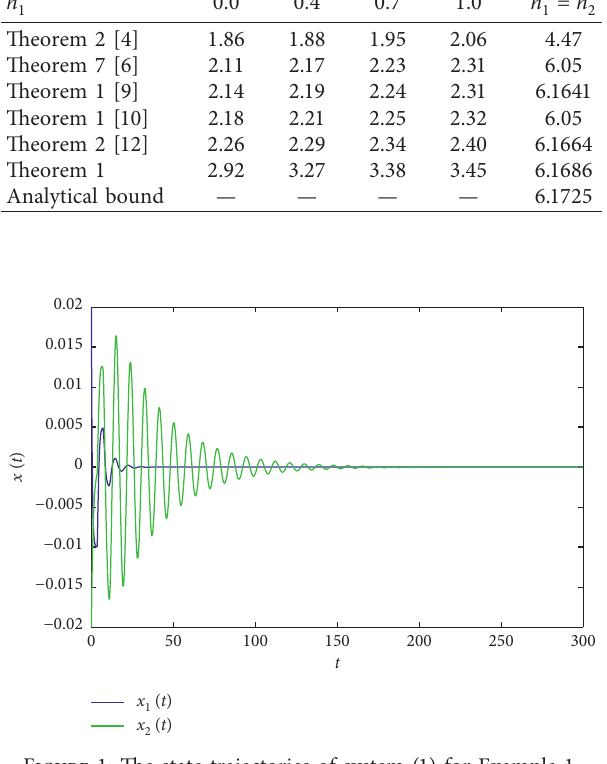
Figure 1: The state trajectories of system (1) for Example 1.